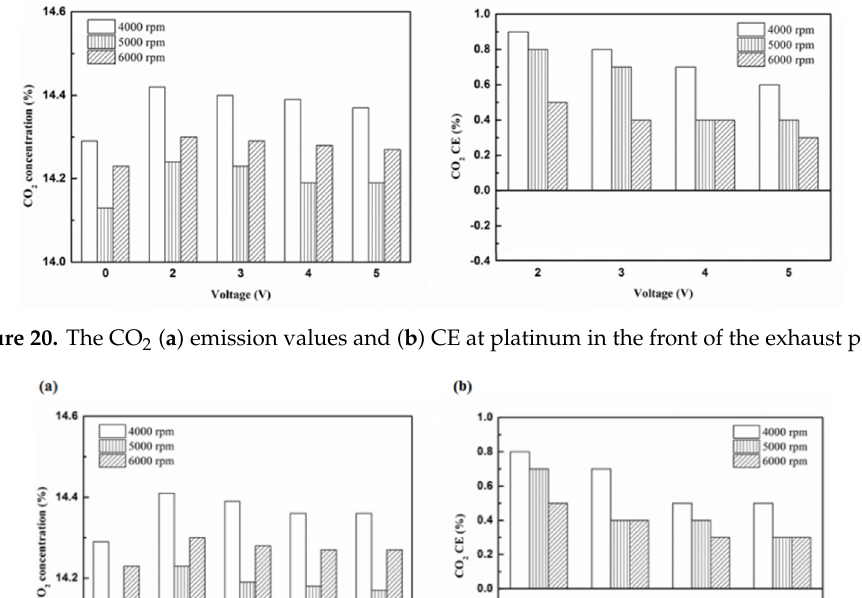
Figure 19. A photographic view of NTP reactor ( a ) platinum and ( c ) iridium alloy before this experiment and ( b ) platinum and ( d ) iridium alloy after this experiment.